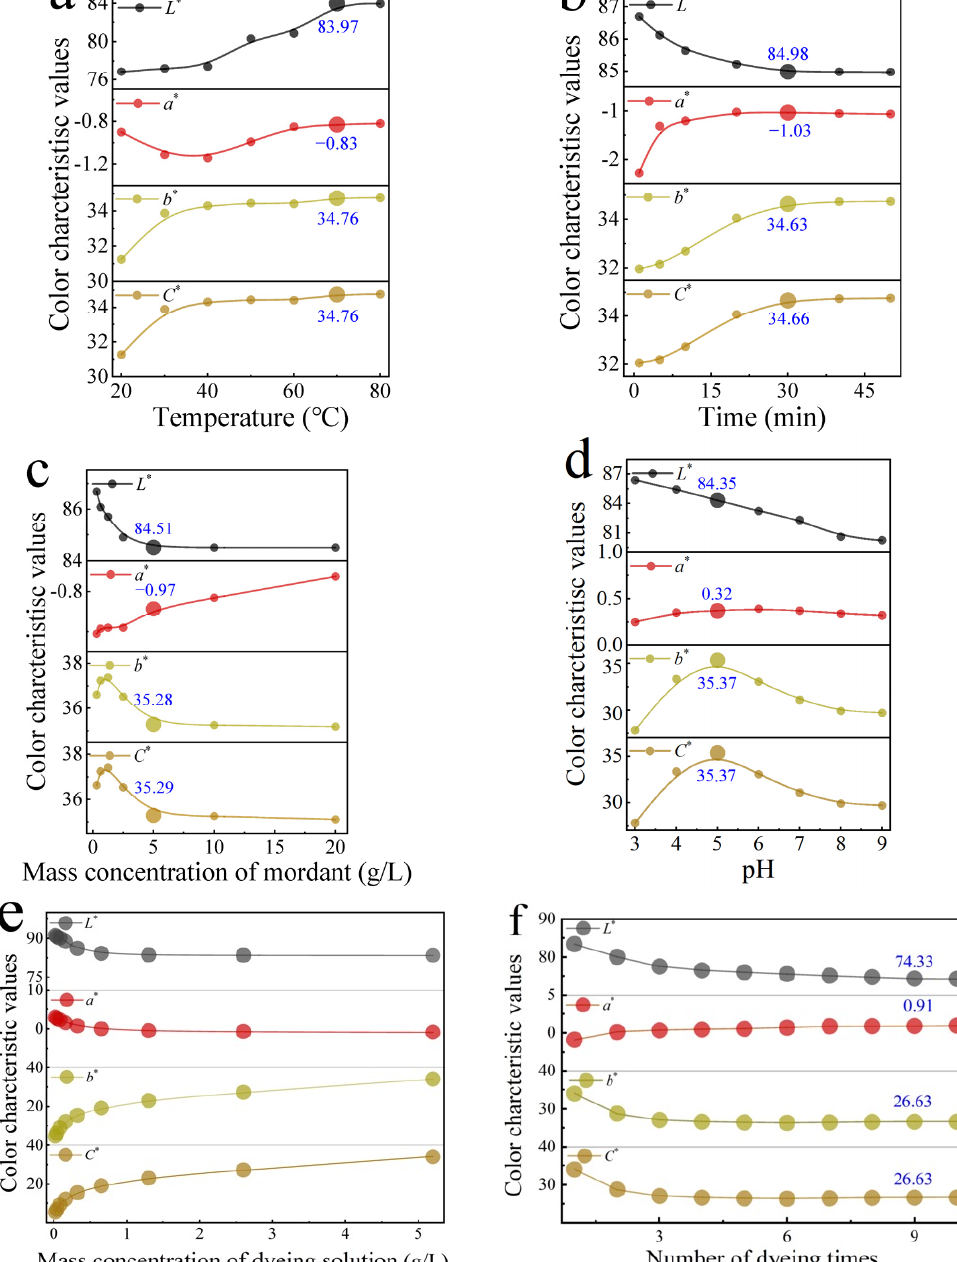
Figure 4. Effect of dyeing parameters of pre-mordanting process on the color characteristic values. ( a ) Dyeing temperature, ( b ) dyeing time, ( c ) mordant concentration, ( d ) pH of the dye solution, ( e ) mass concentration of dye solution, ( f ) number of dyeing